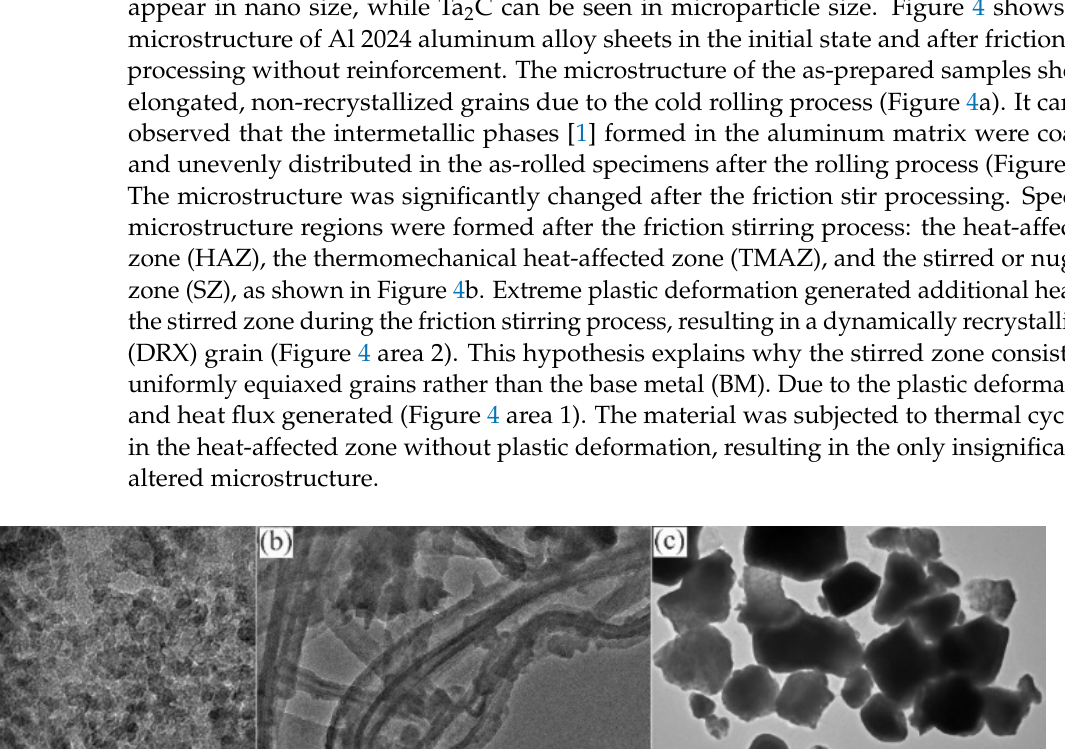
Figure 4. The typical microstructure image ( a ) as-received Al 2024 alloy sheets and ( b ) the friction stir processed zones. Figure 5 shows the microstructure of the fabricated surface nanocomposites for nano- reinforcements, H1 (Figure 5a), H2 (Figure 5b), H3 (Figure 5c), and H4 (Figure 5d). In general, the incorporation of nano-reinforcements into the studied metal matrix, Al 2024, resulted in significant grain refinement in the stirred zone. It is known that the presence of nano-reinforcement particles in the metal matrix during the stirring friction process increases the nucleation centers, resulting in many new grains. Moreover, the nano-rein- forcements prevent grain growth in the stirred zone after the dynamic recrystallization process (DRX) [38]. The average grain size and corresponding aspect ratio of the starting material after FSP and the fabricated surface nanocomposites are listed in Table 5. It can be observed that the average grain size decreased greatly after FSP. Moreover, the grains are almost equiaxed with an aspect ratio of about ≈ 1. The reinforcing particles have led to further refinement in addition to the pure FSP effect. Figure 6 shows the grain size refine- ment of the FSP treated and the fabricated composites with respect to the Al 2024 alloy aluminum sheet in the as-prepared condition. After the FSP process, the grains were re- fined by 22 times of the initial Al 2024 alloy aluminum sheet. The grain refinement in the produced composites varies between 33 and 40 times, depending on the type of reinforce- ment particles.